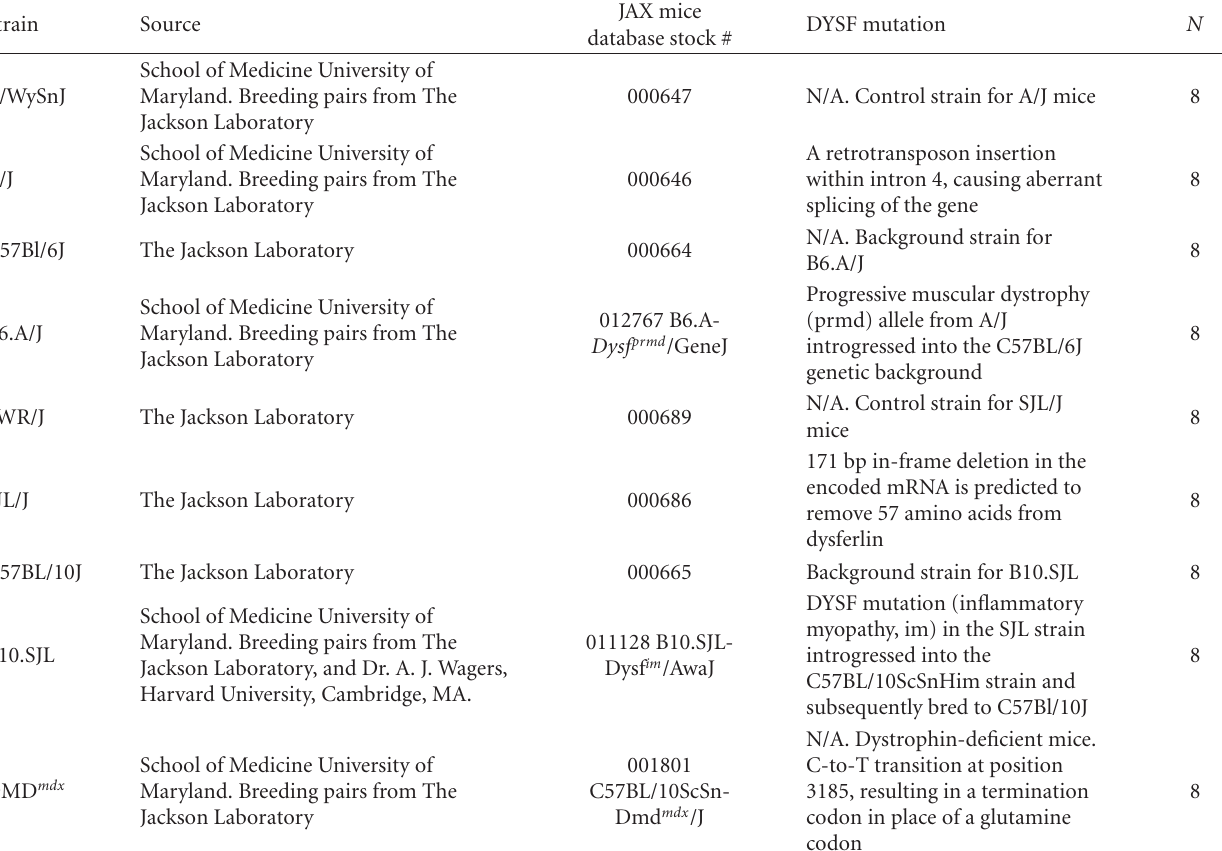
Table 1: Mouse strains. Mouse strains used in the study and number of animals studied per